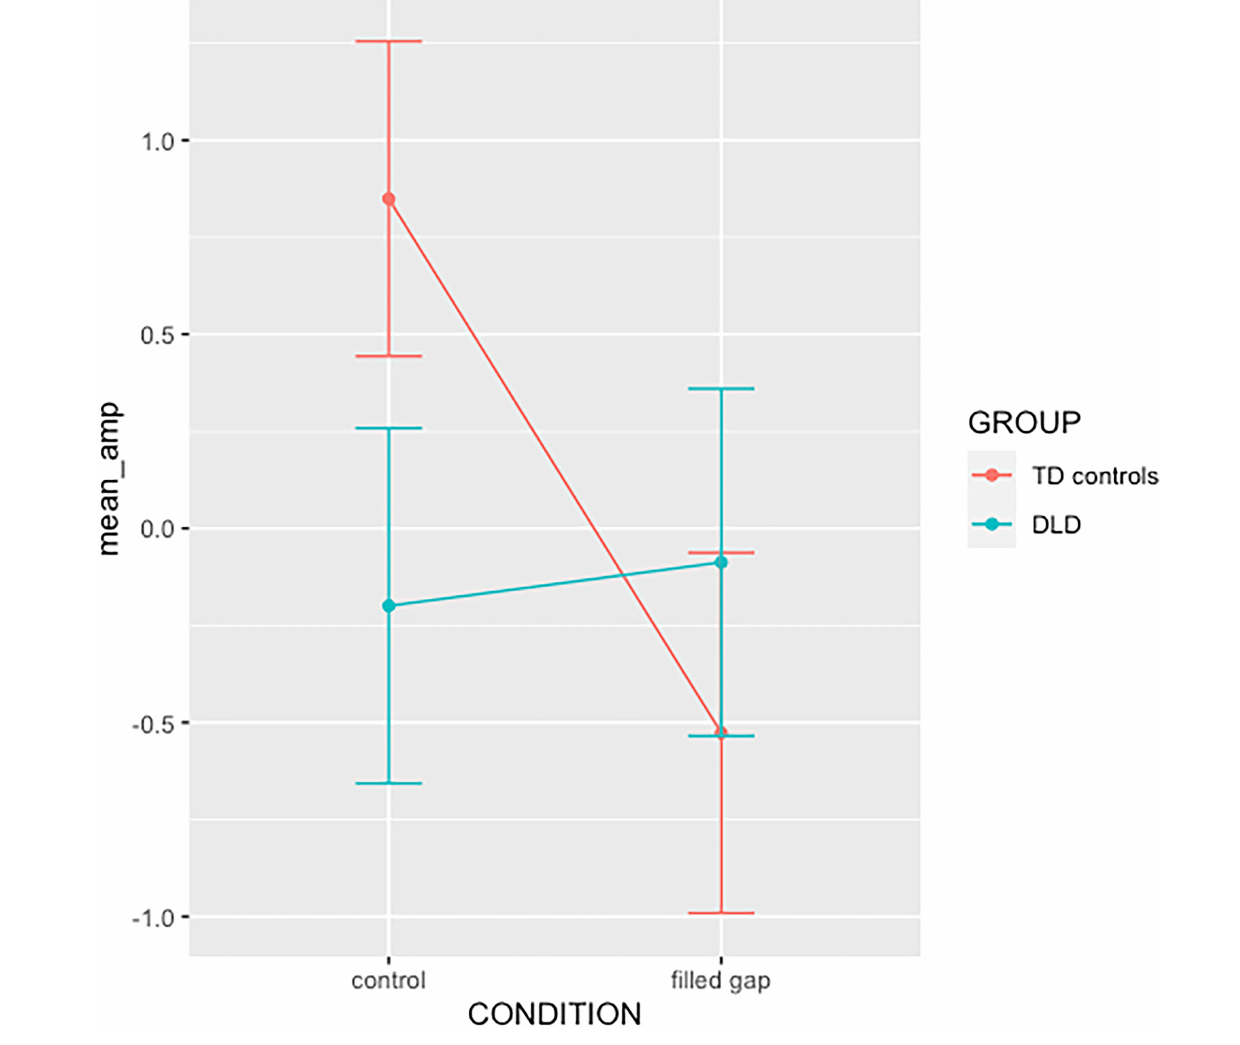
FIGURE 10 | Interaction plot for the 2x2 design GROUP x Condition interaction in TF04SF1. Error bar indicate standard error.